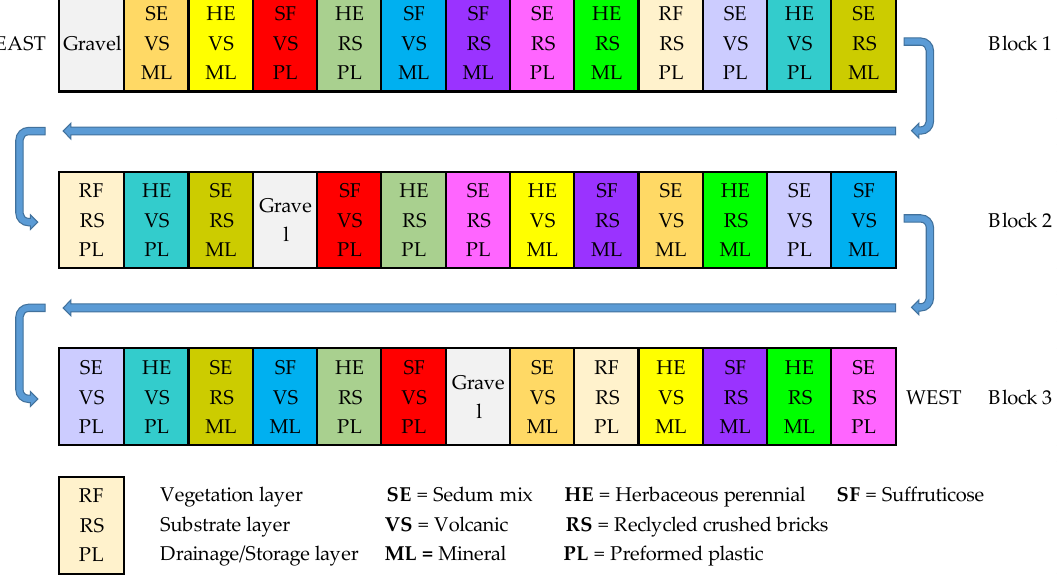
Figure 3. Randomized complete block layout of the experimental site with the indication of the conditions of the substrate, drainage/storage, and vegetation layers of each green roof microcosm.